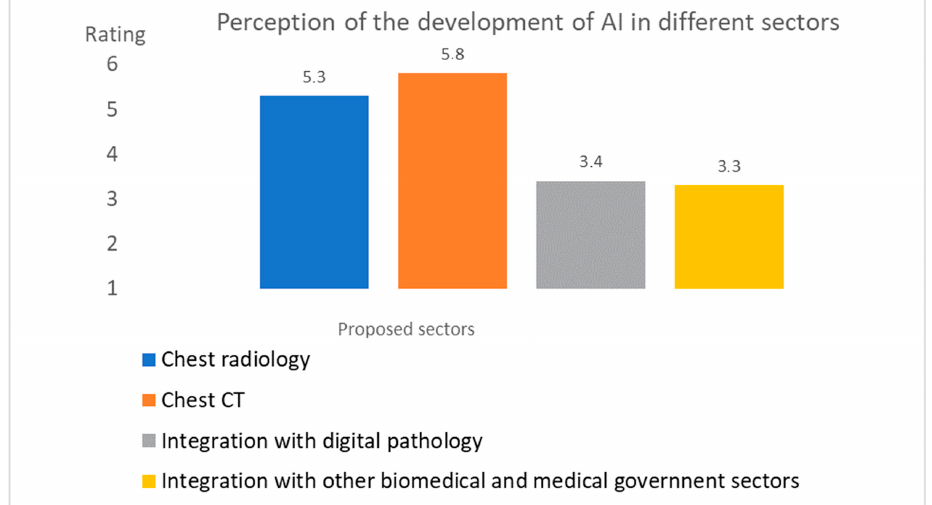
Figure 3. Answers to the Likert scale item #16: “Please indicate your opinion on the degree of AI development during the pandemic in the following areas.”